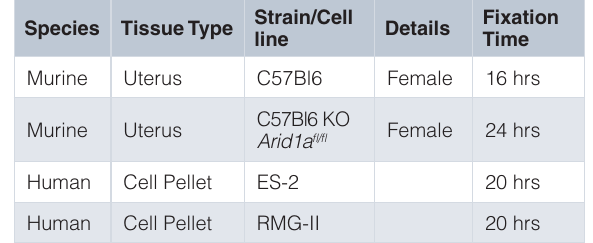
Table 3. Details of tissue and cell pellet used during the validation. Species Tissue Type